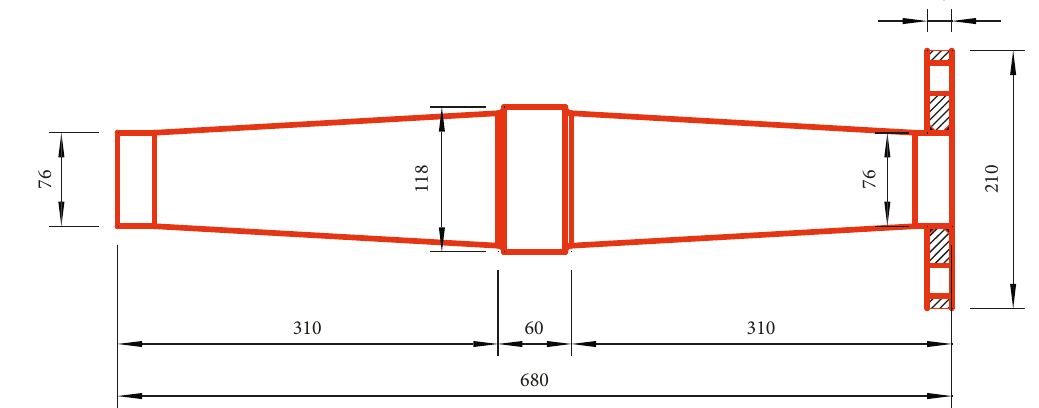
Figure 4: Geometric dimensions of the specimen.